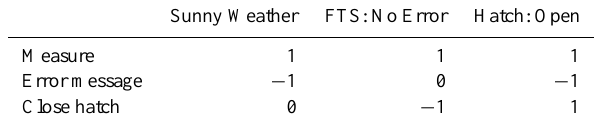
Table A1. Matrix: the matrix has as columns the states of the sub- systems and as rows actions, which follow from a certain system state. If the states of the subsystems (respectively the columns in the matrix) fit a wanted action (respectively a row in the matrix), the action will be communicated by the Master program and exe- cuted (0: false, 1: true, − 1: unimportant). Sunny Weather FTS: No Error Hatch: Open Measure Error